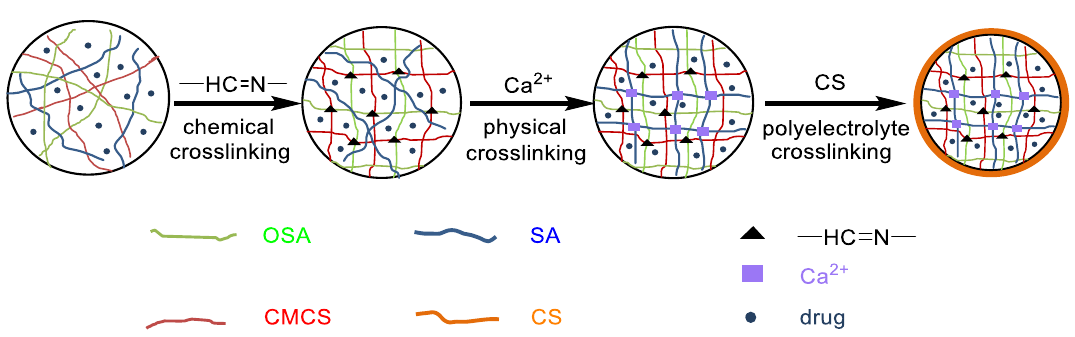
Figure 1. The illustration of five different network structure of hydrogels.